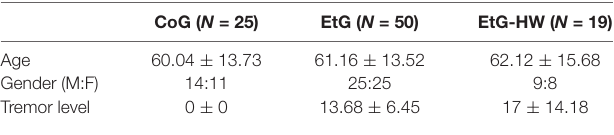
TABLE 1 | Demographic data for handwriting and